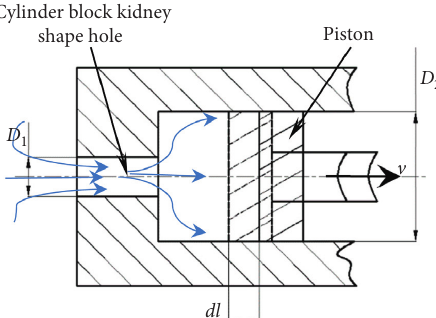
Figure 6: Plunger cavity suction fluid schematic